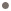
A) Evolution of the percentage of cells that developed polar chemoreceptor clusters during induction of the SOS system in a culture growing in liquid medium. The percentage of S. enterica ΔcheR cells harboring plasmid pUA1127, containing the inducible eYFP::cheR fusion, was quantified at several time points after the addition of either 0.08 or 10 μg mitomycin C/mL or 0.06 μg ciprofloxacin/mL concentration (● or ▲, respectively). Non-treated cells served as the control (□). The results are the mean of at least three independent imaging experiments. Error bars represent the standard deviation. B) Representative fluorescence microscopy images of cells treated for 300 min with either 0.08 or 10 μg mitomycin C/mL or 0.06 μg ciprofloxacin/mL.A control cell not treated with mitomycin C is shown as well.